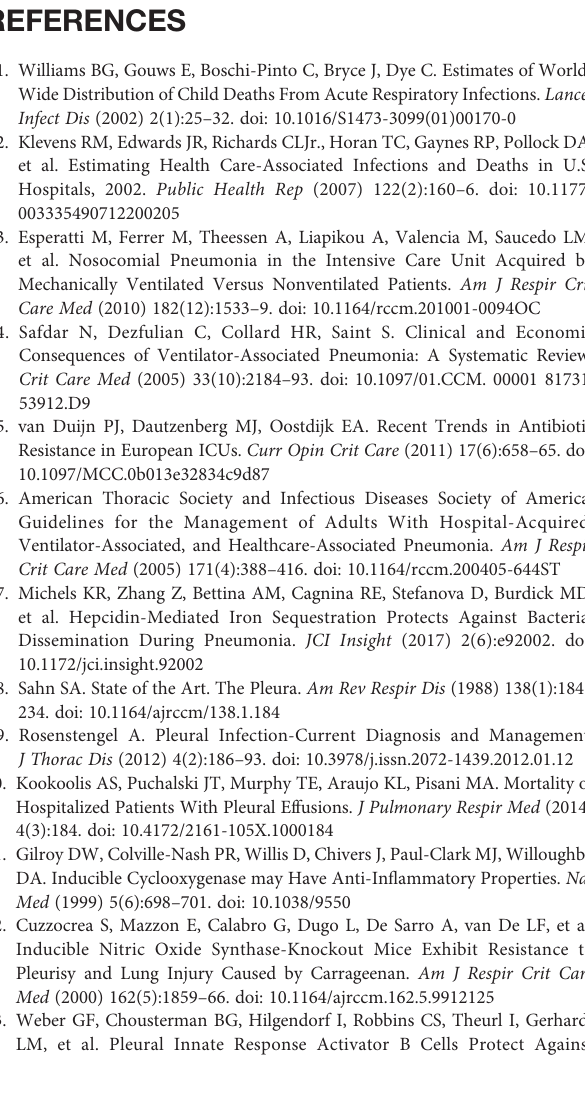
from the PBS group, and the values for the other samples were calculated relatively to this reference. Data are pooled data from at least 2 independent experiments. Data represent mean ± S.E.M. and were analyzed by the two-tailed paired or unpaired t-test. *p<0.05; **p<0.01; ***p<0.001. Supplementary Figure 6 | Speci fi c pleural space stimulation induces pulmonary immune response. (A) Relative mRNA expression of Il-1 b in lungs 24h after i.pls. injection of PBS, 20µg of LPS or 100ng of TNF a (n=6-14 mice). The expression level wasarbitrarilysetto1foronesamplefromthePBSgroup,andthevaluesfortheother samples were calculated relatively to this reference. (B) Enumeration of neutrophils in lungs 24h after i.pls. injection of PBS or TDB (n=7-9 mice). Data are pooled data from atleast2independentexperiments.Datarepresentmean±S.E.M.andwereanalyzed by the two-tailed unpaired t-test. *p<0.05; **p<0.01; ***p<0.001. Supplementary Figure 7 | Speci fi c depletion of pleural space macrophages after clodronate treatment. (A – D) Mice received i.pls. injection ofliposome control (white) or clodronate (grey) and 2 days later they were sacri fi ced. (A) Enumeration of CD115 + F4/80 + macrophages and neutrophils in PS. (B) Percentage of CD115+ F4/80+ macrophages in PS. (C, D) Enumeration of CD115+ F4/80+ macrophages in lungs (C) and BALF (D) . Data are pooled data from at least 2 independent experiments. Data represent mean ± S.E.M. and were analyzed by the two-tailed unpaired t-test. *p < 0.05; **p < 0.01; ***p <